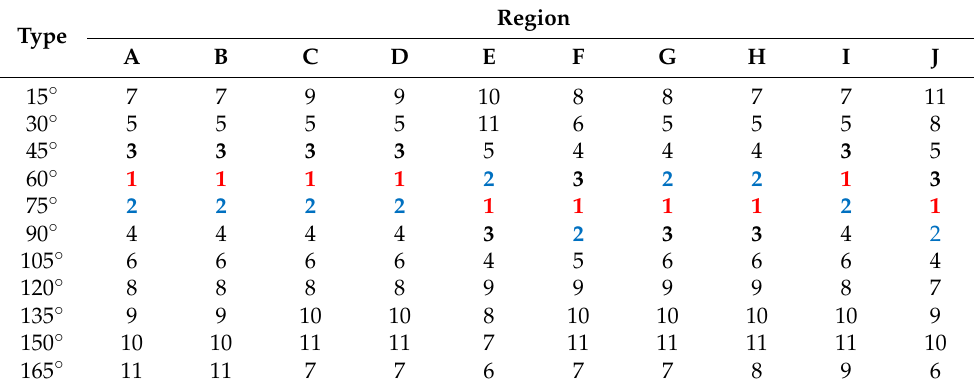
Table 10. Ranks of optimized installation angles for a fixed louver.